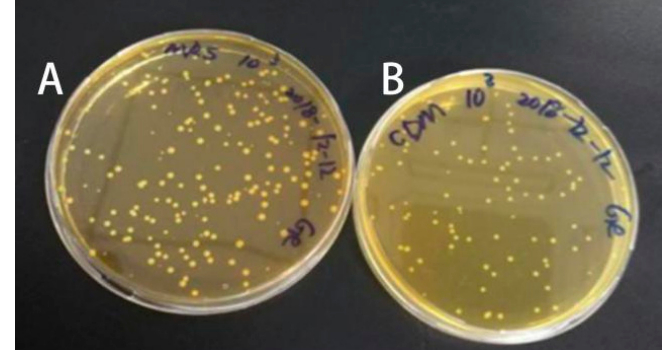
Figure 2. Bacterial colonies obtained upon incubation of the diluted mixture of 11 different pickle juices on MRS plate ( A ) and chemically defined medium (CDM) plate ( B ).